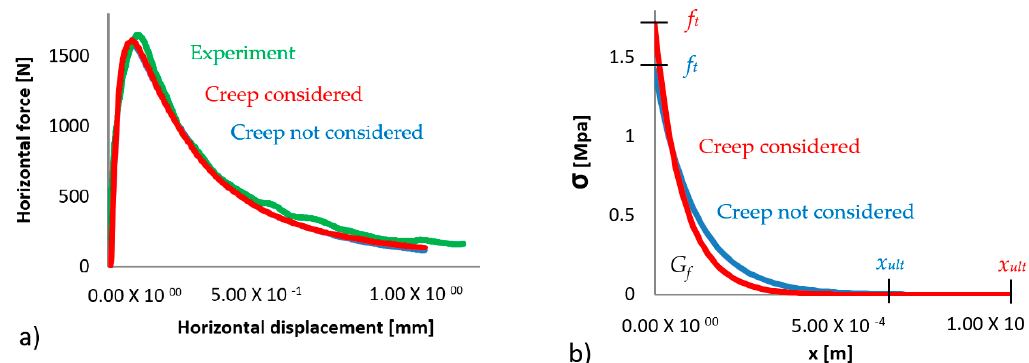
Figure 10. Load-displacement diagram ( a ) and strain-softening behavior ( b ) at 1370 ◦ C.